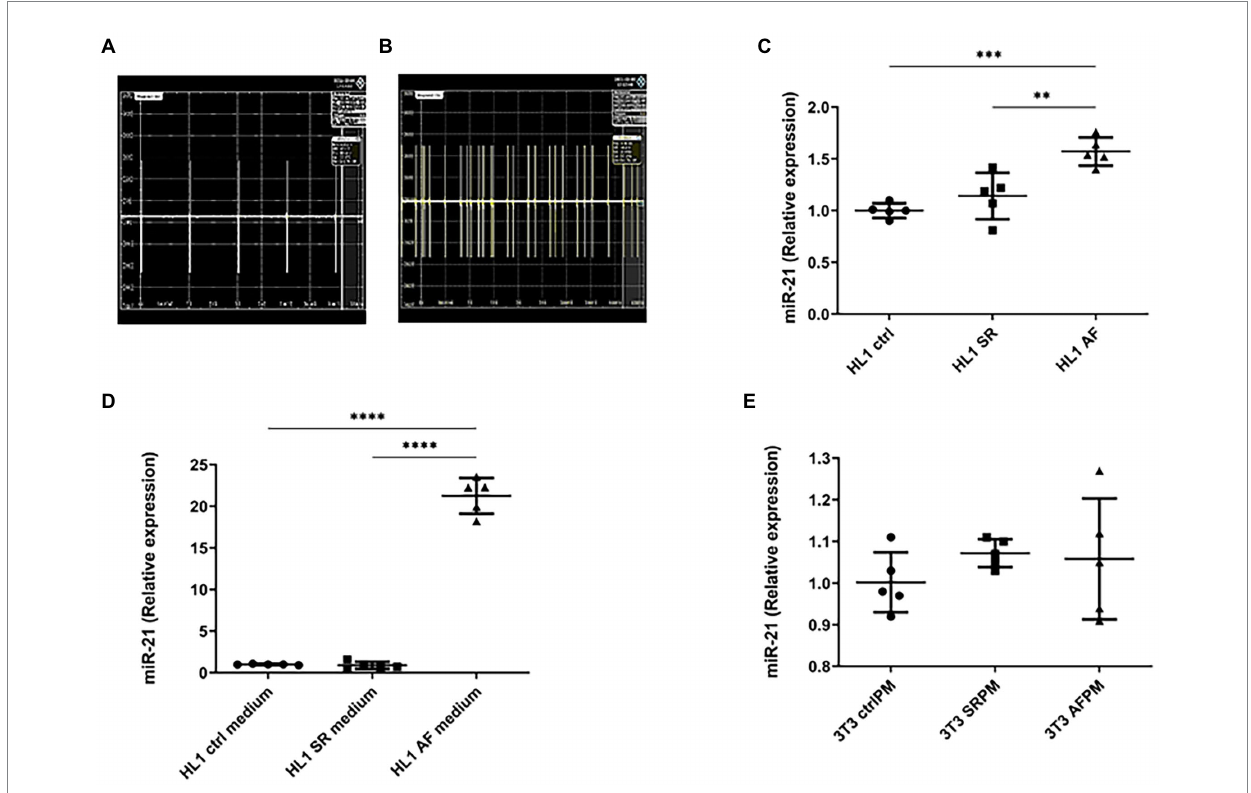
FIGURE 2 AF model with cultured murine cardiomyocytes (HL-1 cells) and fibroblast (NIH/3 T3 cells). (A) Sinus rhythm was simulated using a regular wave form at 25 V 6 ms 1 Hz. (B) For the simulation of AF, a faster, irregular pacing protocol was used (25 V 6 ms 5 Hz, 80% variability). (C) After 4.5 h of pacing, increased miR-21 expression under tachyarrhythmic conditions could be observed in the HL-1 cardiomyocytes. (D) miR-21 concentration in the medium of cardiomyocytes that were held under tachyarrhythmic conditions was strongly increased, whereas no release of miR-21 to the medium under SR conditions could be observed. (E) No increase in miR-21 expression in NIH/3 T3 fibroblast was observed, when treated with control, SR and AF paced medium from HL1 cardiomyocyte cells. (C–E) Representative data out of 3 similar experiments. Data are expressed as mean ± SEM. **** p <